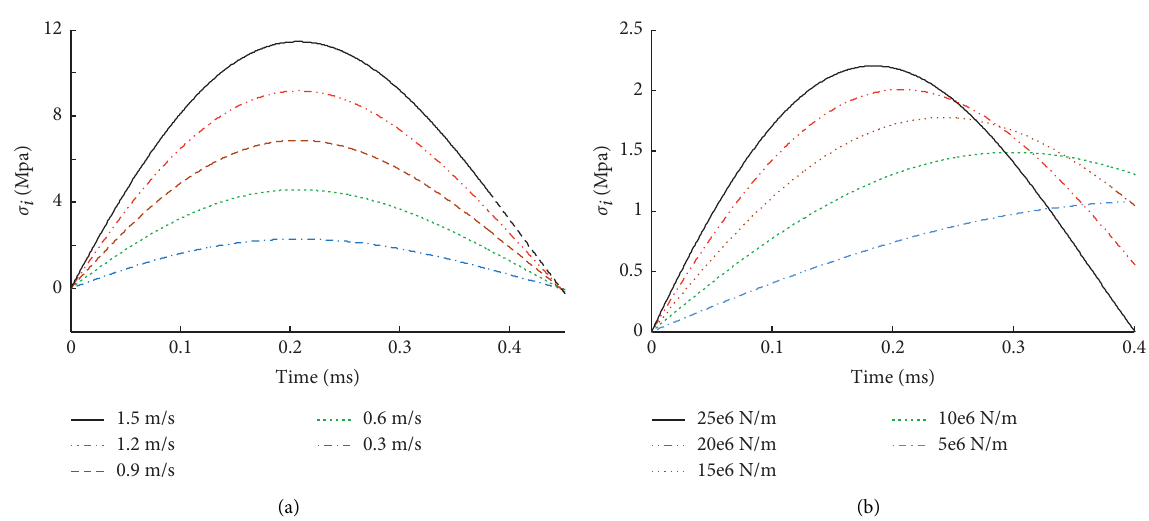
Figure 4: The waveform diagram of incident impact stress. (a) Curves of impact stress vs. impact velocity. (b) Curves of impact stress vs. hammer contact stiffness.